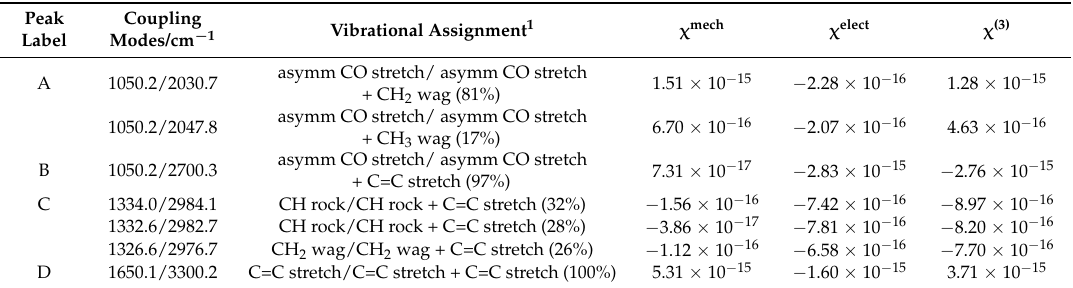
Table 1. The vibrational mode pairs corresponding to the characteristic cross peaks in the β - aminoxylated LM2A and their respective contributions.